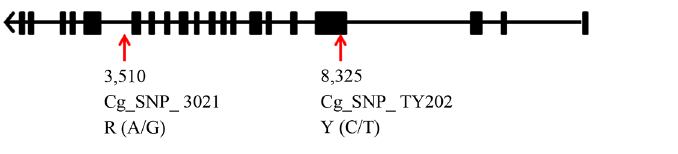
Fig 1. Location of the two associated SNPs in Cg_GD1 .